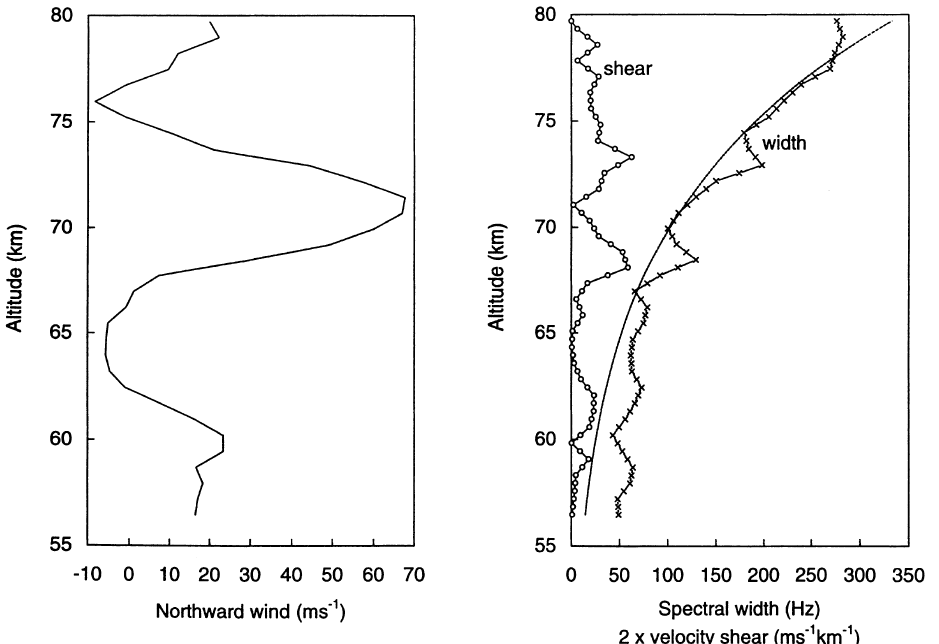
Fig. 6. As Fig. 5, but for the UHF radar. The smooth curve is the model spectral width assuming no negative ions